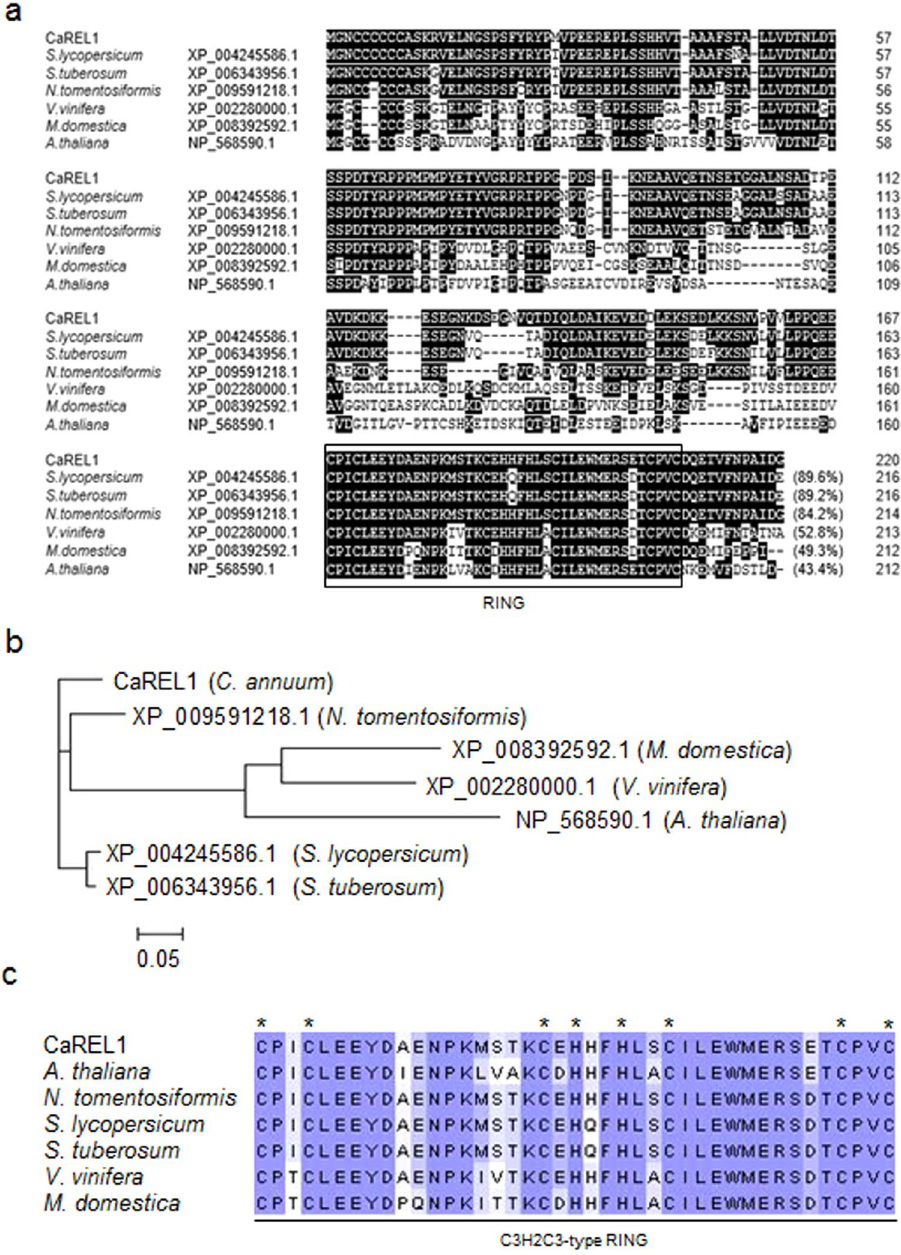
Figure 1. Amino acid sequence analysis of the pepper CaREL1 ( Capsicum annuum RING type E3 Ligase 1) protein. ( a ) Comparisons of the deduced amino acid sequence of the CaREL1 protein (accession no. KU557246) with those of the Solanum lycopersicum (accession no. XP_004245586.1), Solanum tuberosum (accession no. XP_006343956.1), Nicotiana tomentosiformis (accession no. XP_009591218.1), Vitis vinifera (accession no. XP_002280000.1), Malus domestica (accession no. XP_008392592.1), and Arabidopsis thaliana (accession no. NP_568590.1) proteins. Identical amino acid residues are highlighted in black, and the box reveals the Really Interesting New Gene (RING) zinc finger domain. ( b ) Phylogenetic tree analysis of the CaREL1 protein. Blast search was performed using the deduced amino acid sequences of the CaREL1 gene, and the top-ranked sequences from each plant species were collected. ( c ) Alignment of the RING zinc finger C3H2C3-type domain. Asterisks indicate conserved cysteine (C) and histidine (H)